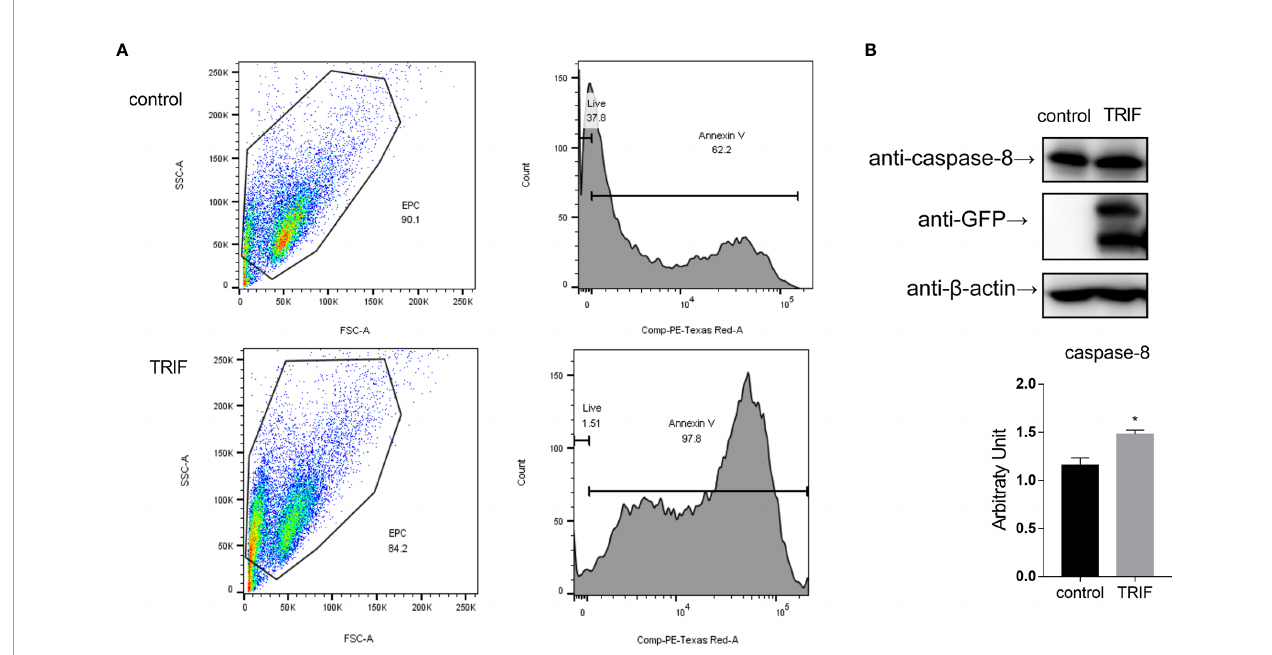
FIGURE 9 | Carp TRIF induces apoptosis. (A) EPC cells in 24-well plates were transfected with pEGFP-N1 (control) or carp TRIF-EGFP. The early apoptosis cells were stained with Annexin V-mCherry. Flow cytometric analysis was undertaken to detect Annexin V in cells. The percent of apoptotic cells were determined using the FlowJo software. (B) 293T cells were transfected with pEGFP-N1 (control) or carp TRIF-EGFP. After transfection for 24 h, the cell lysates were collected. Western blot was performed with anti-caspase-8 Abs. The level of caspase-8 was quanti fi ed by densitometry analysis of the band intensity using the Image J software, and normalized to the b -actin. Data were shown as the mean ± SD of the relative ratios of the intensity (caspase-8/ b -actin). All experiments were repeated at least three times. * P <